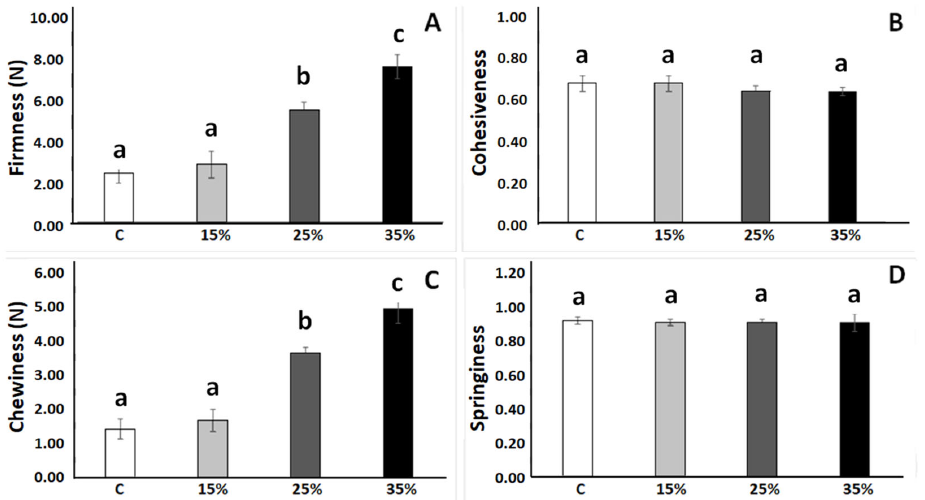
Figure 3. Crumb texture parameters: wheat bread (control: C) and breads with mixtures of oat–wheat flours: 5, 15, and 25%. ( A ). Firmness. ( B ). Cohesiveness. ( C ) Chewiness. ( D ) Springiness. Different letters indicate significant differences between formulations ( p < 0.05).